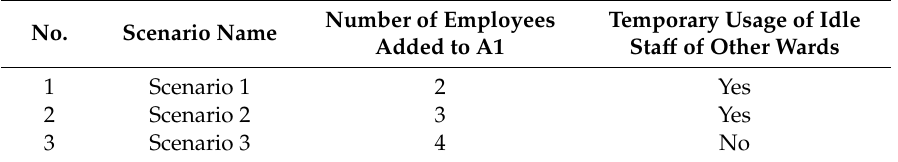
Table 3. The details of the proposed